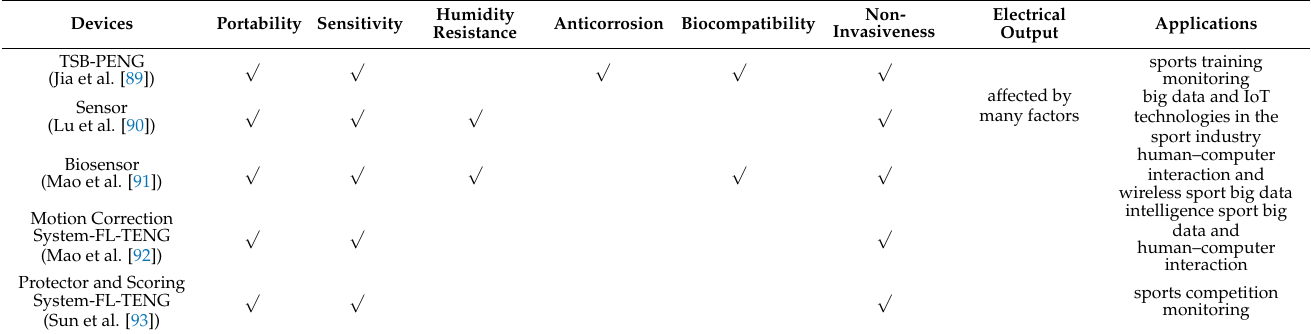
Table 3. Features and application comparison of different devices in our